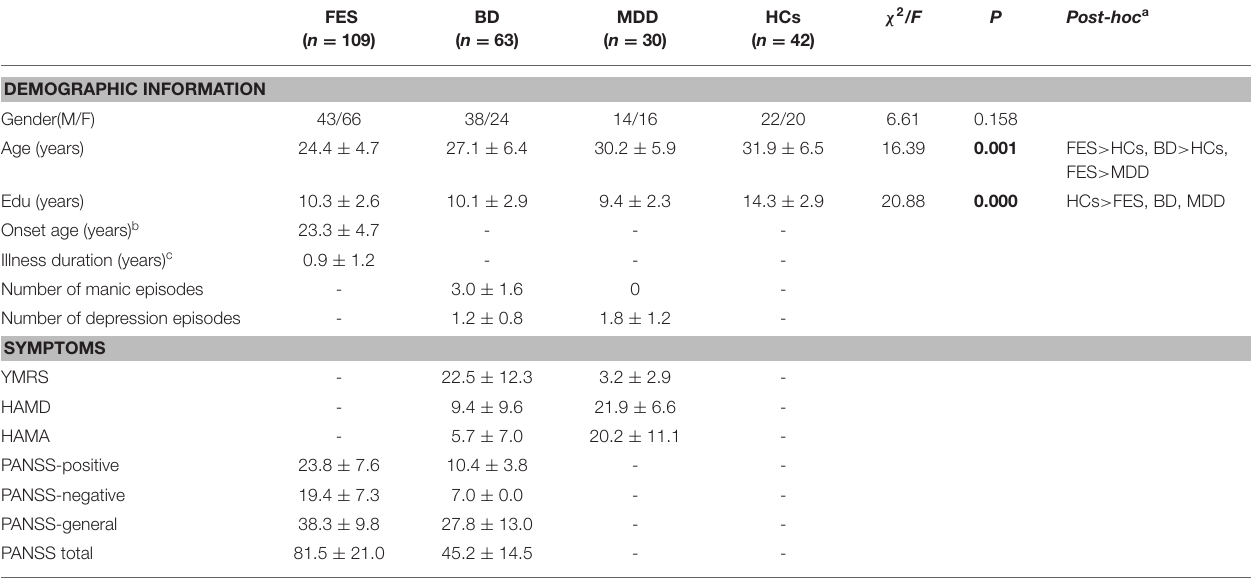
TABLE 1 | Demographic and clinical characteristics of patients with FES, BD, MDD, and